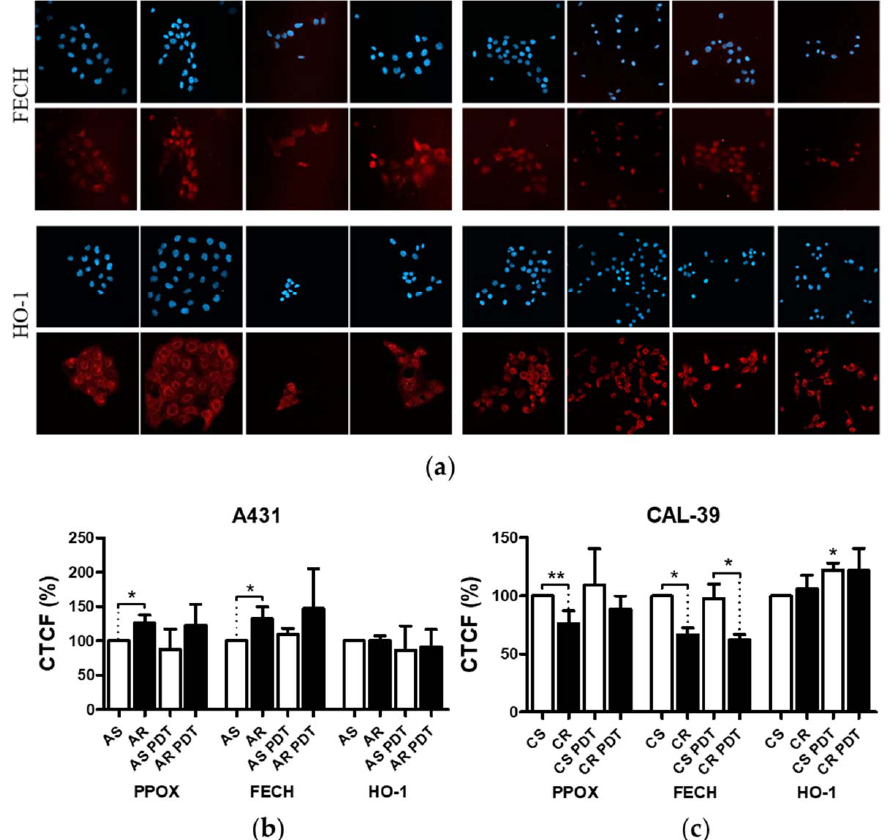
Figure 4. Analysis of the levels of PPOX, FECH, and HO-1. ( a ) Images of stained cells, before and after PDT treatment. ( b ) Graph with percentage values of corrected total cell fluorescence (CTCF) of untreated, parental cells. ( c ) Graph with percentage values of corrected total cell fluorescence (CTCF) of CAL ‐ 39 cell lines. Asterisks indicate the statistical significance of differences between cells after PDT and untreated control, and between sensitive and resistant cells calculated by Mann–Whitney test (* p ≤ 0.05, ** p ≤ 0.01).